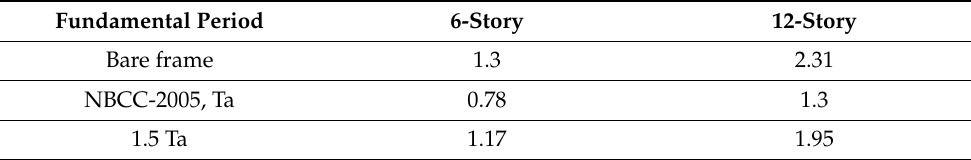
Table 12. Fundamental period (sec). form previous